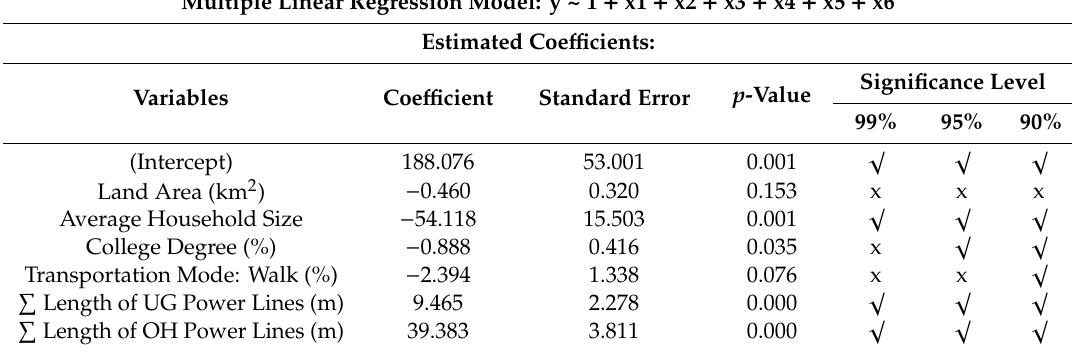
Table 2. Model results for Hurricane Hermine-induced power